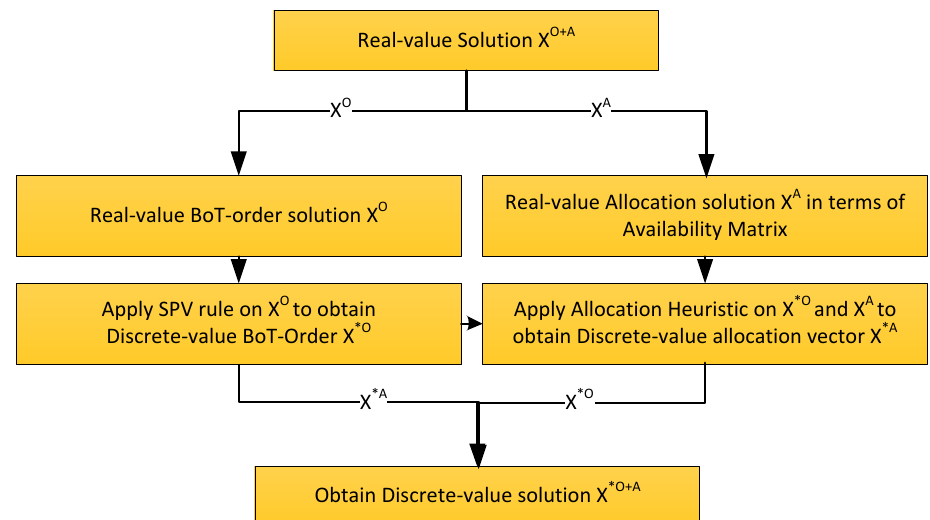
Figure 4. Discretization mechanism for producing discrete-value solution [13].